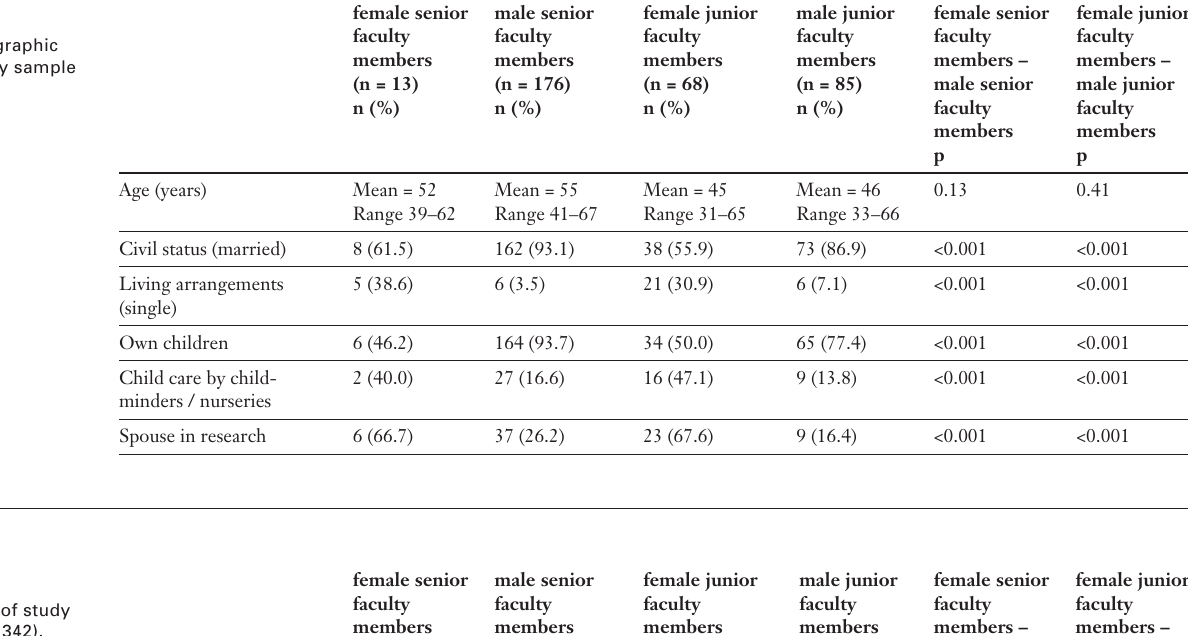
Career data of study sample (n =